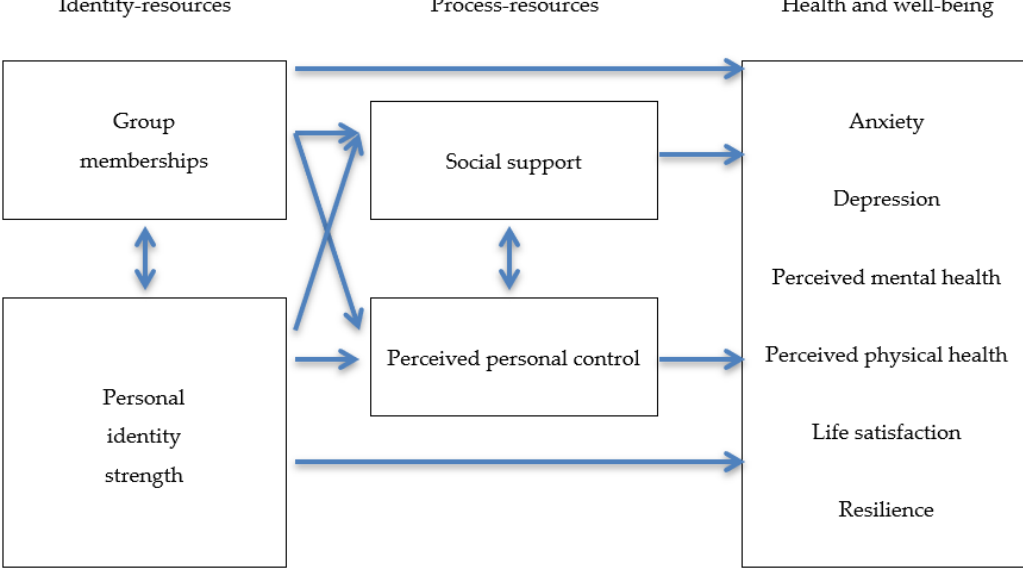
Figure 1. Proposed model on the relationships between identity-resources, process-resources and health and well-being outcomes. Source: Adapted from [5] (p. 347).